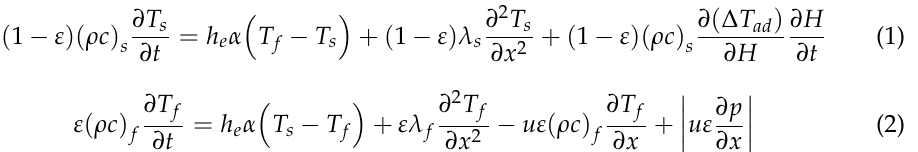
Figure 2. Schematic diagram of the numerical model.